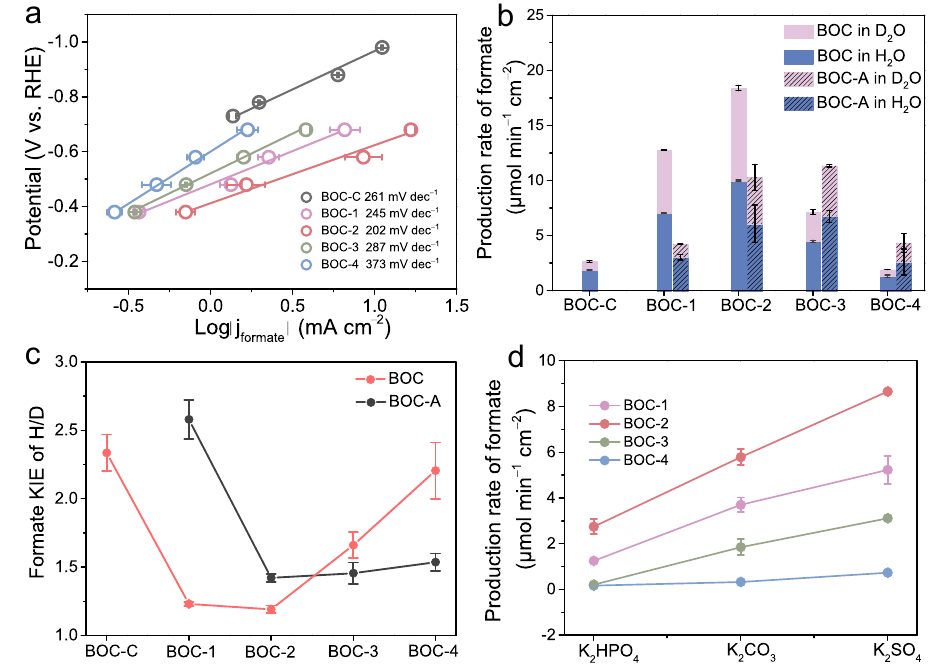
Fig. 3 | Mechanism analysis. a Tafel plots of different samples. b The production rates of formate in 0.5M KHCO 3 -H 2 O (bluecolumn) and 0 . 5M KHCO 3 -D 2 O (purple column). The columns with shadows represent samples after thermal treatment. c The KIE value of H/D for different samples. The red and black lines represent